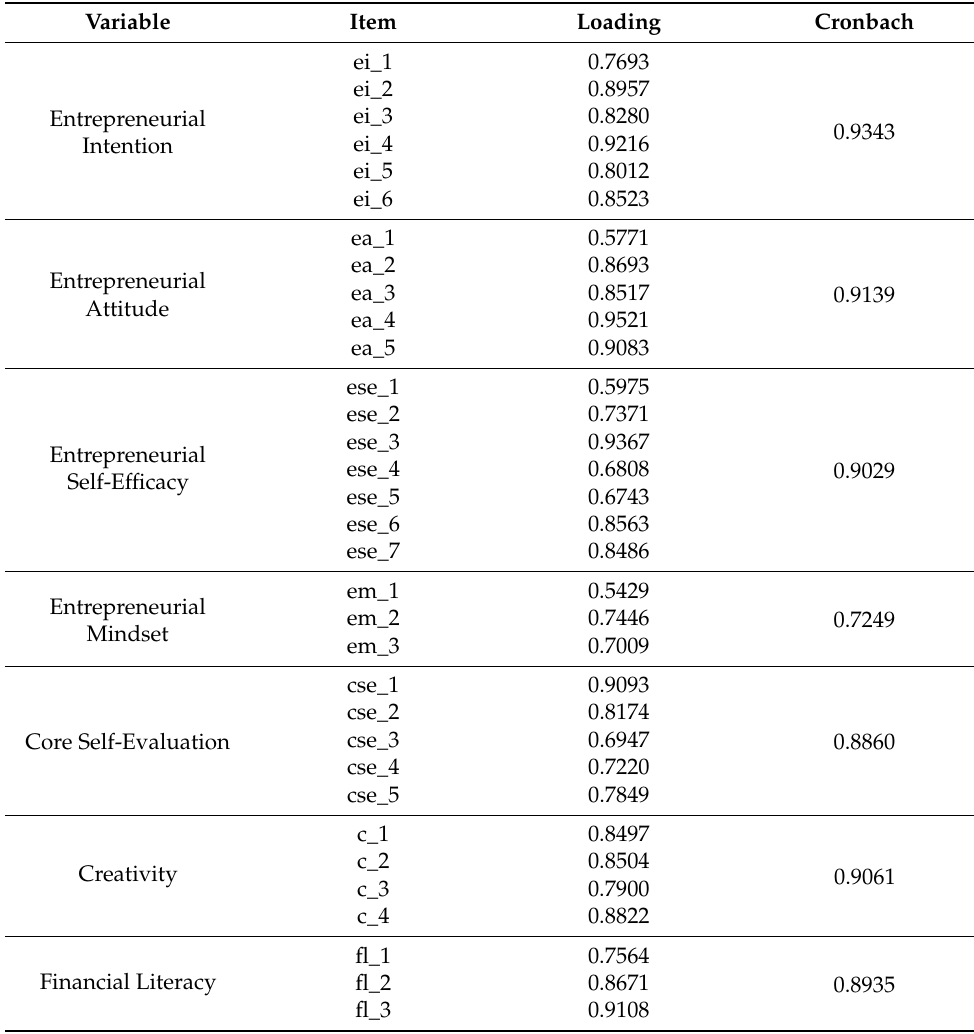
Table 4. Factor loadings and Cronbach’s alpha values obtained from the factor analysis conducted on the post-program